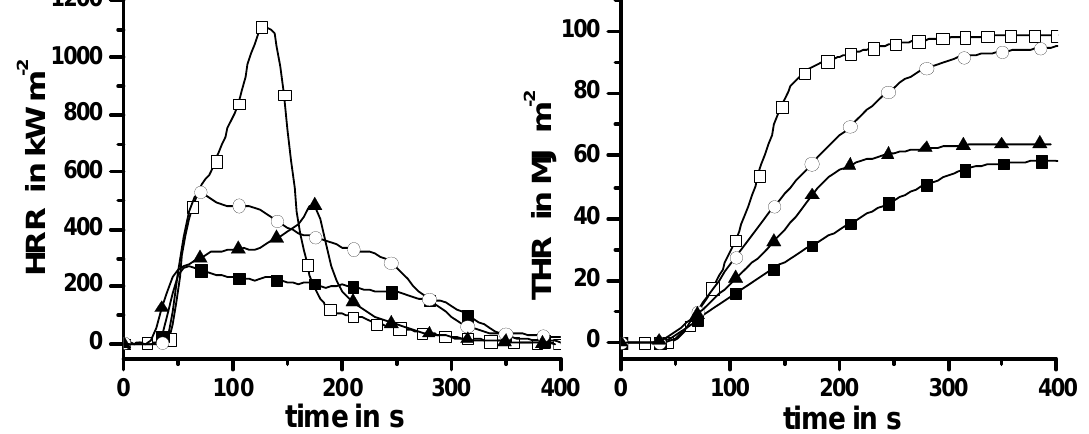
Figure 11. Heat release rate (HRR) and total heat release (THR) of HIPS (open squares), HIPS/Pr (filled triangles), HIPS/ Mg(OH) (open circles) and HIPS/Pr/Mg(OH) (filled 2 2 squares). HIPS and HIPS/Pr show the typical HRR curve of a non-charring material; and HIPS/Pr/ Mg(OH) , that of residue-forming material. Adding Pr HIPS/Mg(OH) 2 2 reduces the HRR and THE by flame inhibition; Mg(OH) reduces the HRR mainly by 2 introducing a